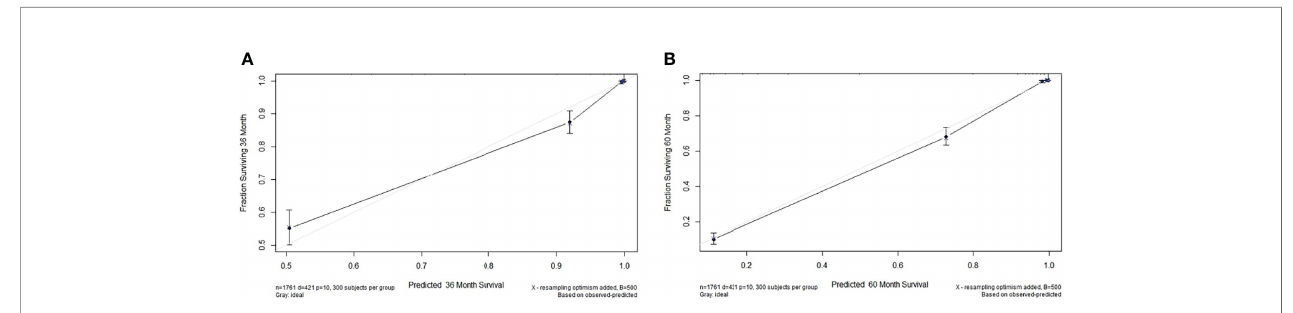
FIGURE 5 | (A) The calibration plots of the nomogram for 3-year overall survival. (B) The calibration plots of the nomogram for 5-year overall